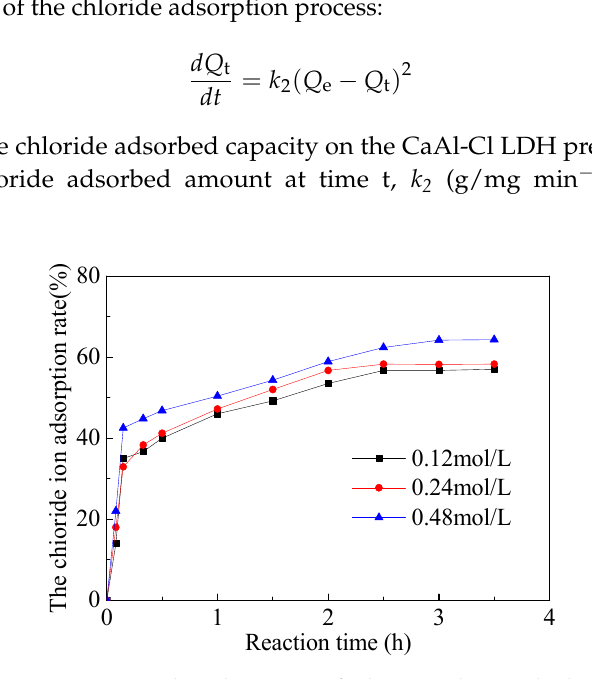
Table 4. Comparison between the measured and estimated Q e from the pseudo-second-order model.